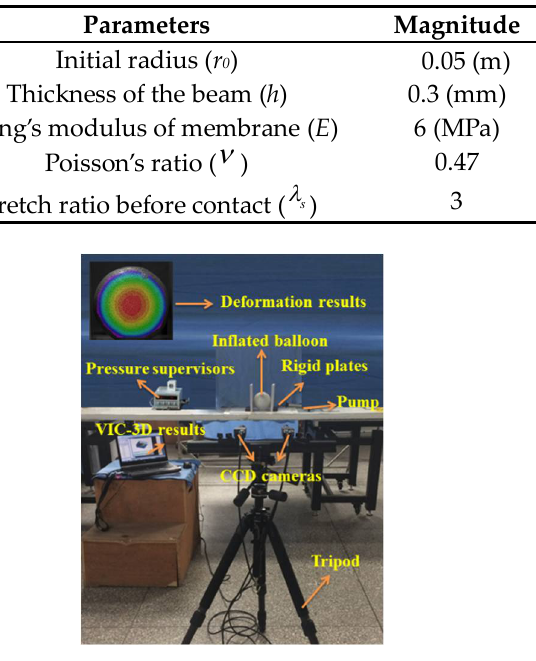
Figure 2. Setup of the contact experiment.